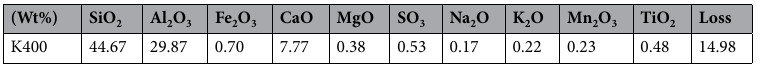
Table 4. The chemical composition of K400